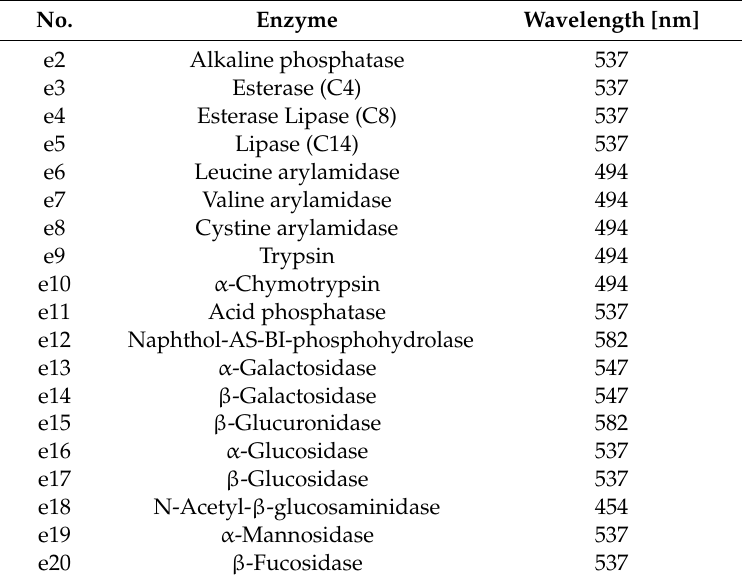
Table3. Listofhydrolyticenzymestested, usingtheAPIZYMsystemandthecharacteristicwavelengths, at which the absorbance of the products of the enzymatic reactions was